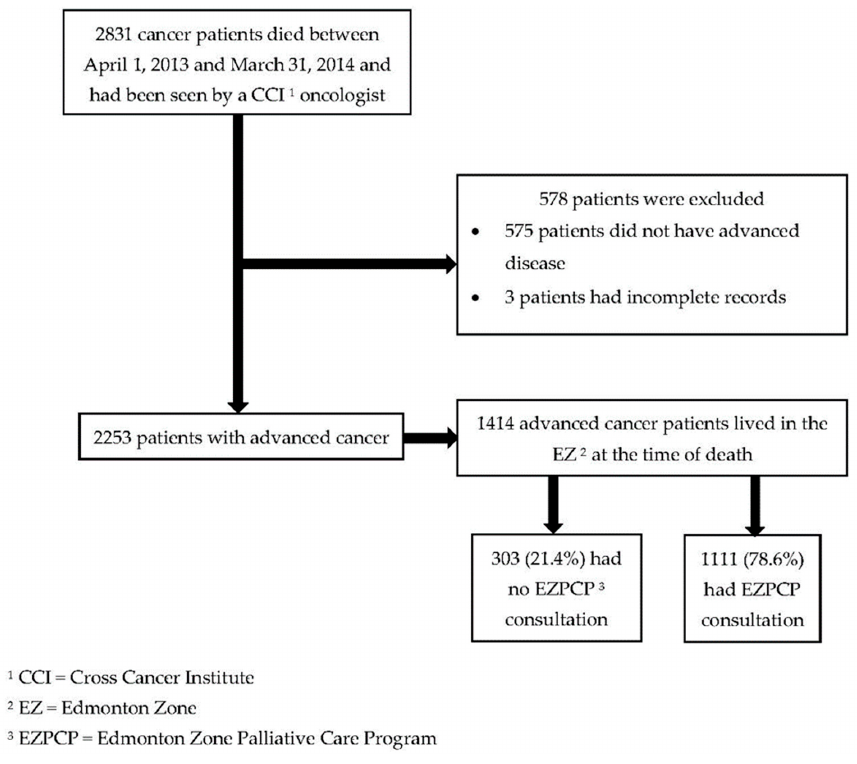
Figure 1. Patient flow chart.